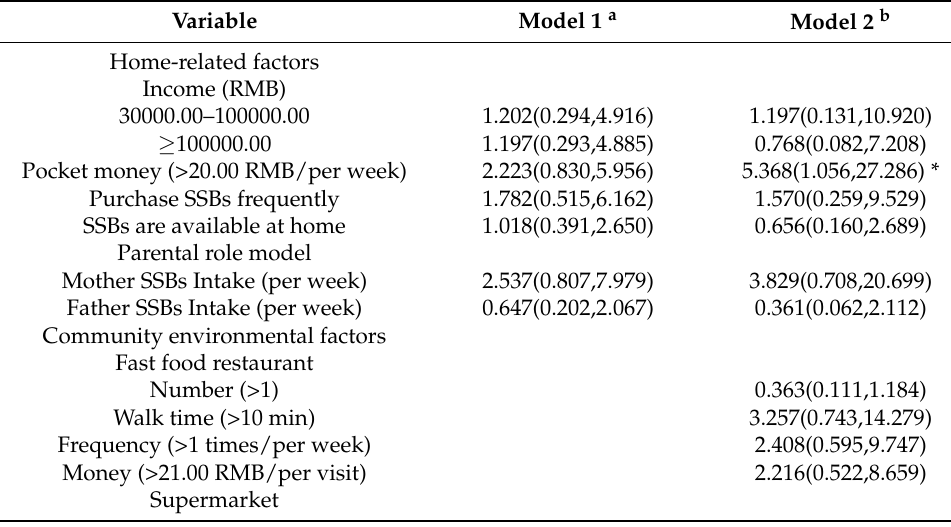
Table 8. Factors associated with beverages intake in obesity